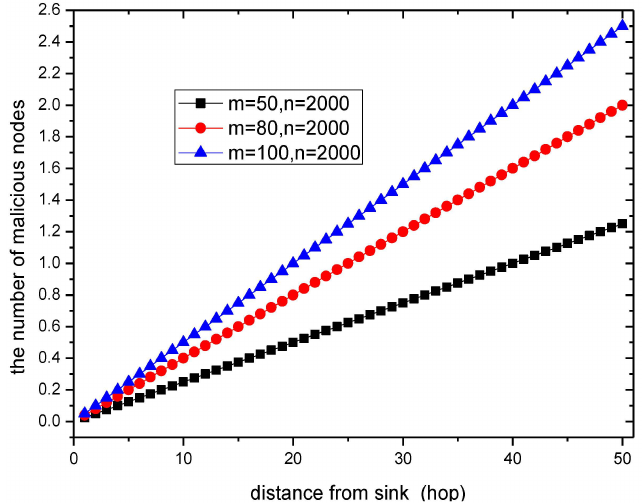
Figure 6. The number of malicious nodes in a routing path.